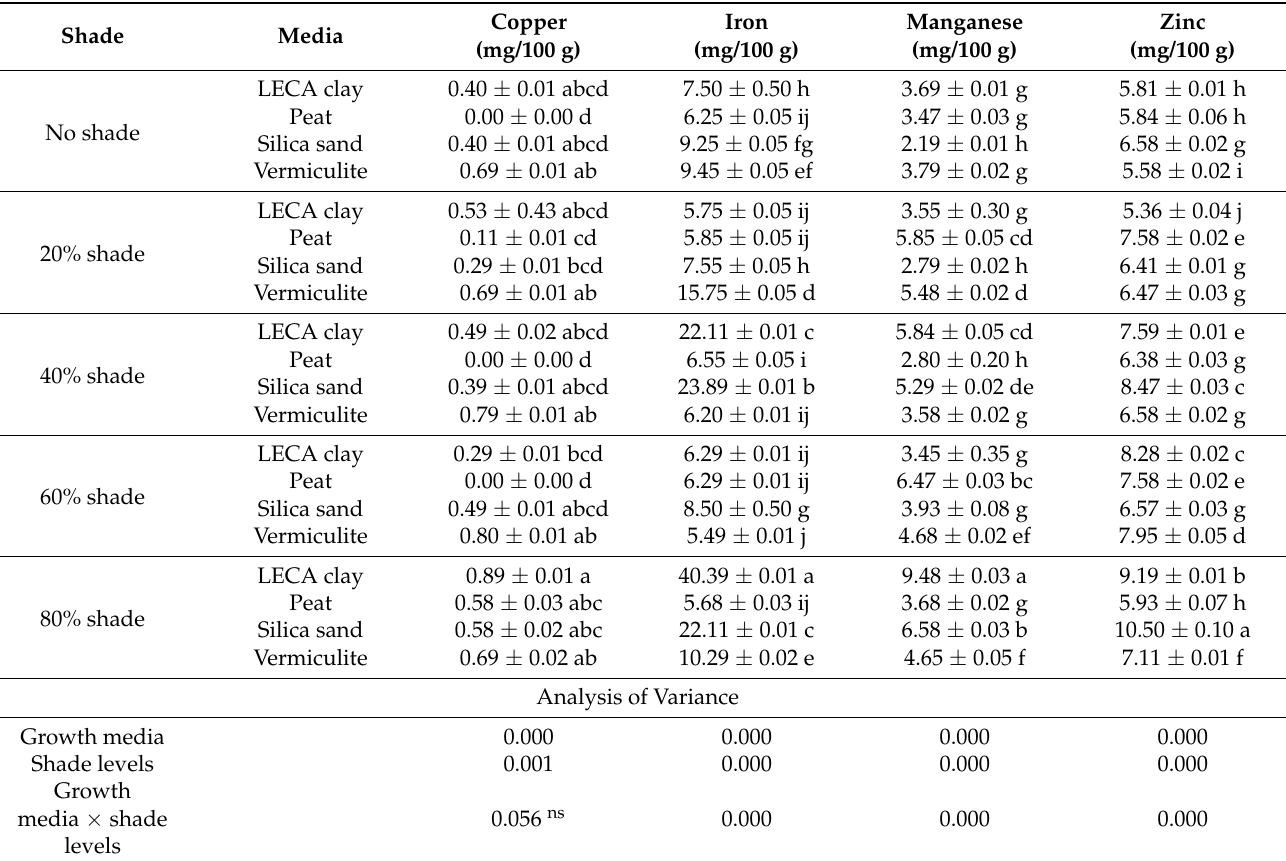
Table 4. The effect of different growth media and shade levels on micronutrients analysis in the flower buds of T. divaricata